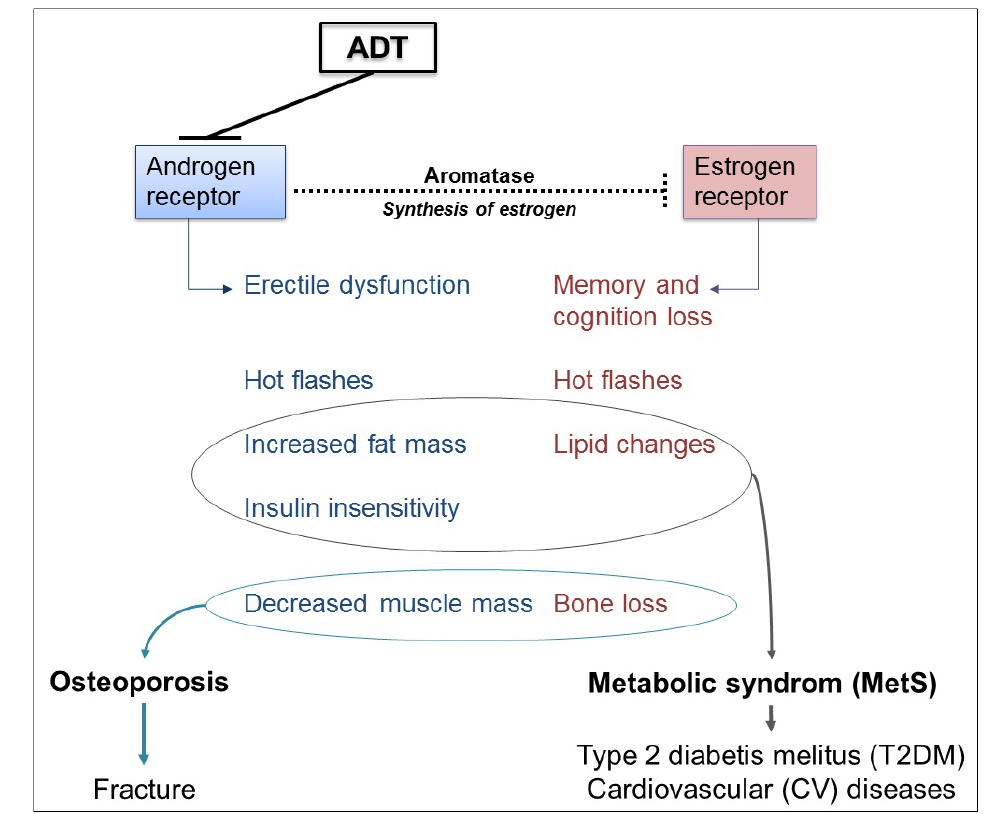
Figure 2. Side effects associated with androgen deprivation therapy